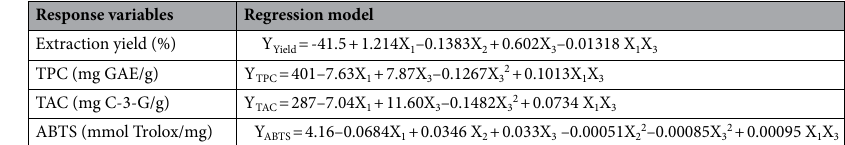
Table 3. Regression models as a function of independent variables for the response variables of the rambutan peel extract in terms of actual levels. X 1 , X 2 and X 3 represented the temperature (°C), extraction time (min) and ethanol concentration (% v/v), respectively. TPC total phenolic content, mg GAE/g milligram gallic acid equivalents per gram extract, TAC total anthocyanin content, mg C-3-G/g milligram cyanidin-3-O-glucoside per gram extract, ABTS 2,2 ′ -azino-bis-3-ethylbenzothiazoline-6-sulphonic acid; mmol Trolox/mg millimole Trolox equivalents per milligram extract.